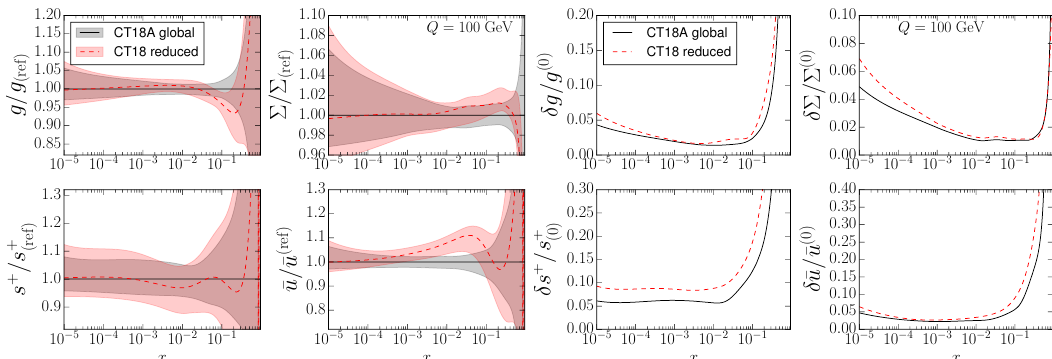
Figure 1: Comparison of the CT reduced fit relative to the CT18A global fit, the ratio of the central values is shown in the left plots and the uncertainties are compared in the right plots. The gluon, singlet ( Σ ), total strangeness ( s + = s + ¯ s ) and anti-up (¯ u ) are compared. The baseline for the ratio is the CT18A global fit.